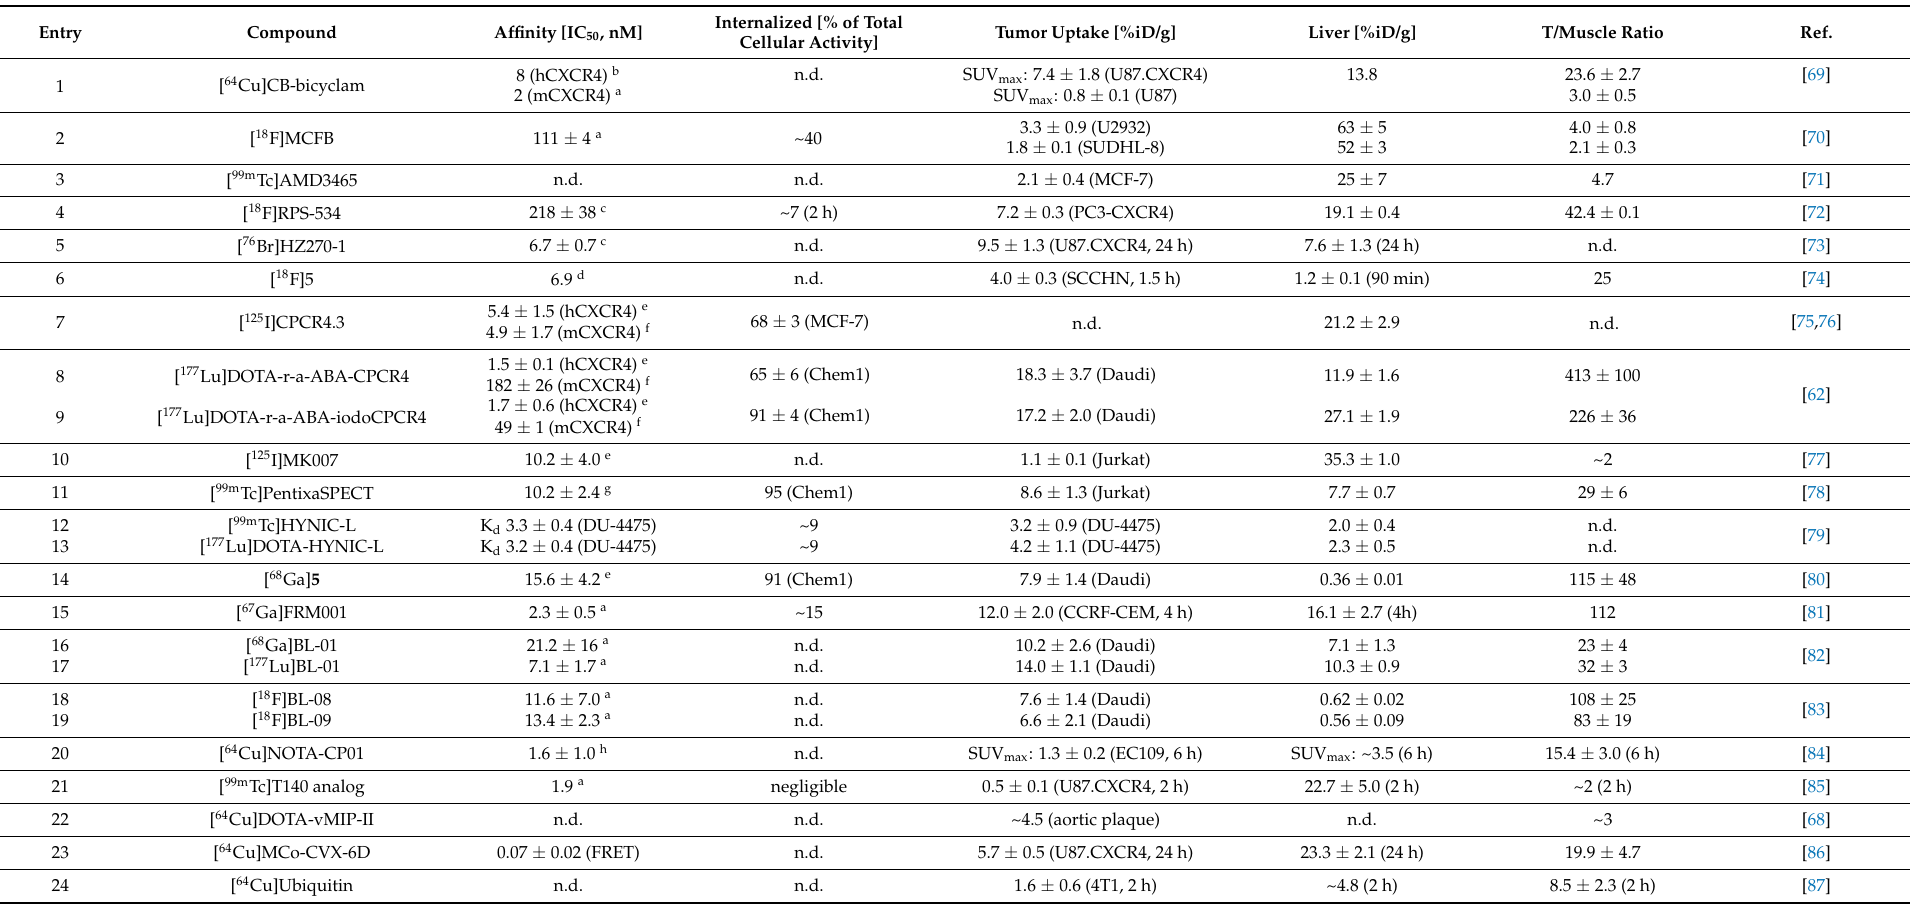
Table 1. Summary of recently developed novel CXCR4-targeted imaging agents (2019–2021). If not stated otherwise in the table, all internalization and biodistribution data were obtained at 1 h incubation or at 1 h p.i. respectively, and internalization studies were performed in the cell line used for tumor